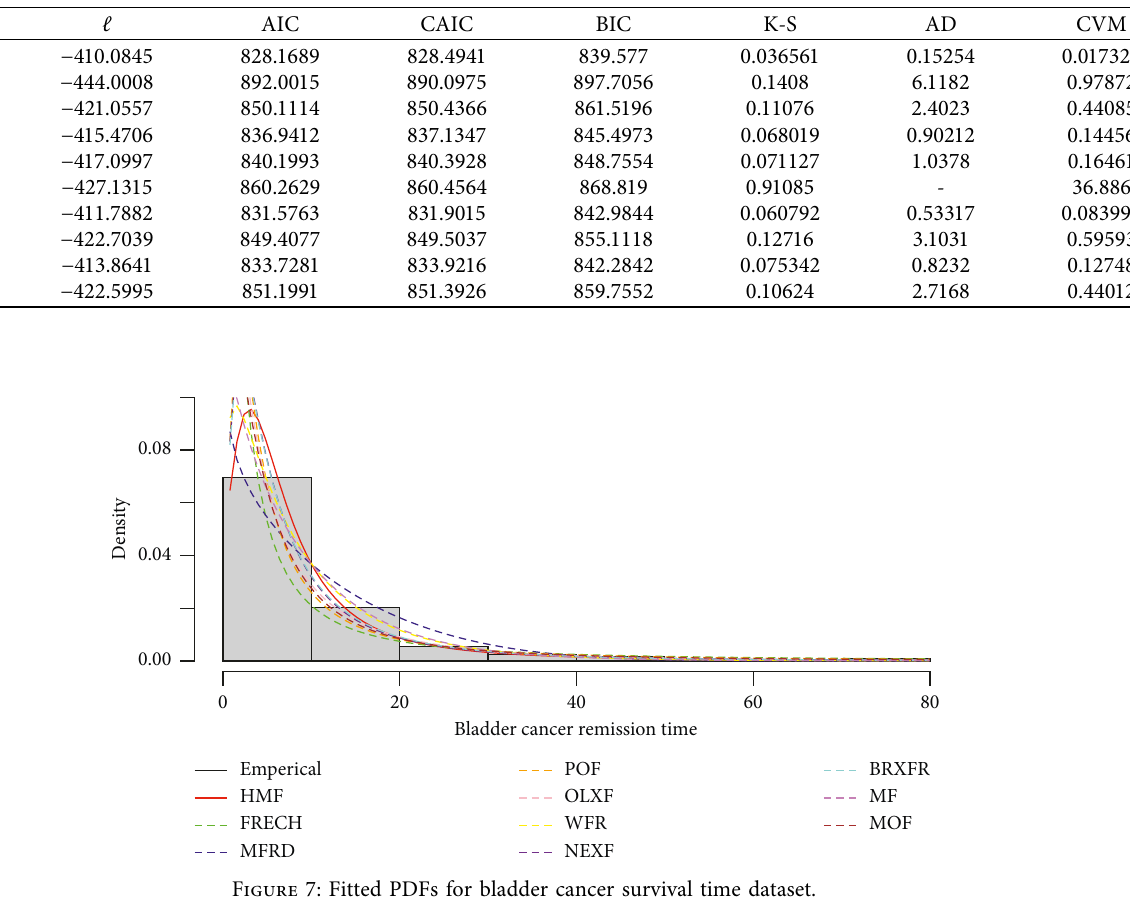
Table 14: Log-likelihood and comparison criteria for bladder cancer dataset.